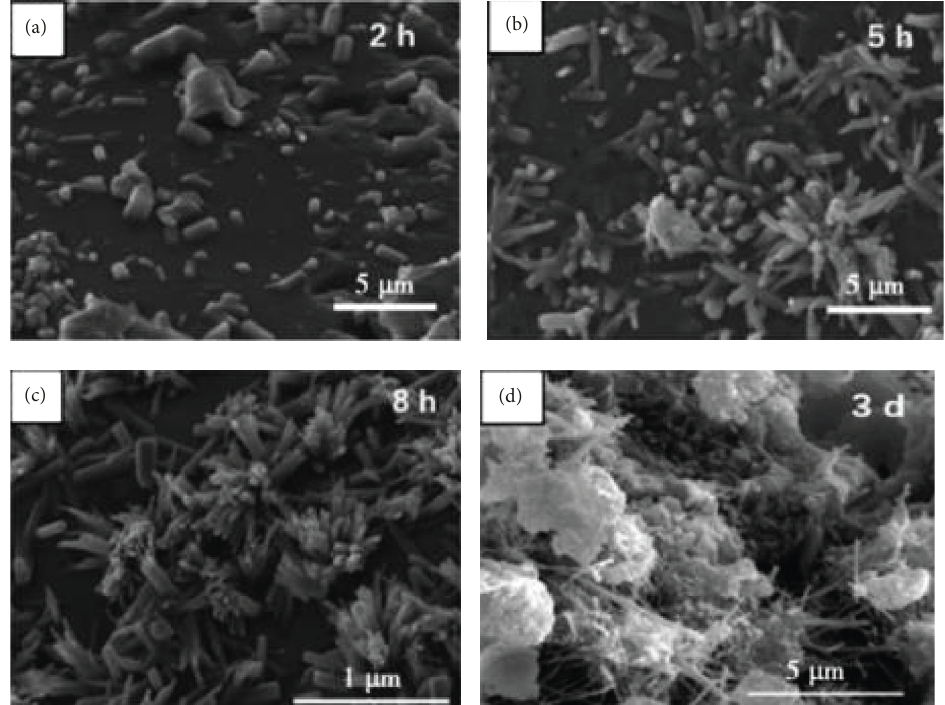
Figure 13: Variation of C-S-H morphology with hydration time [27,